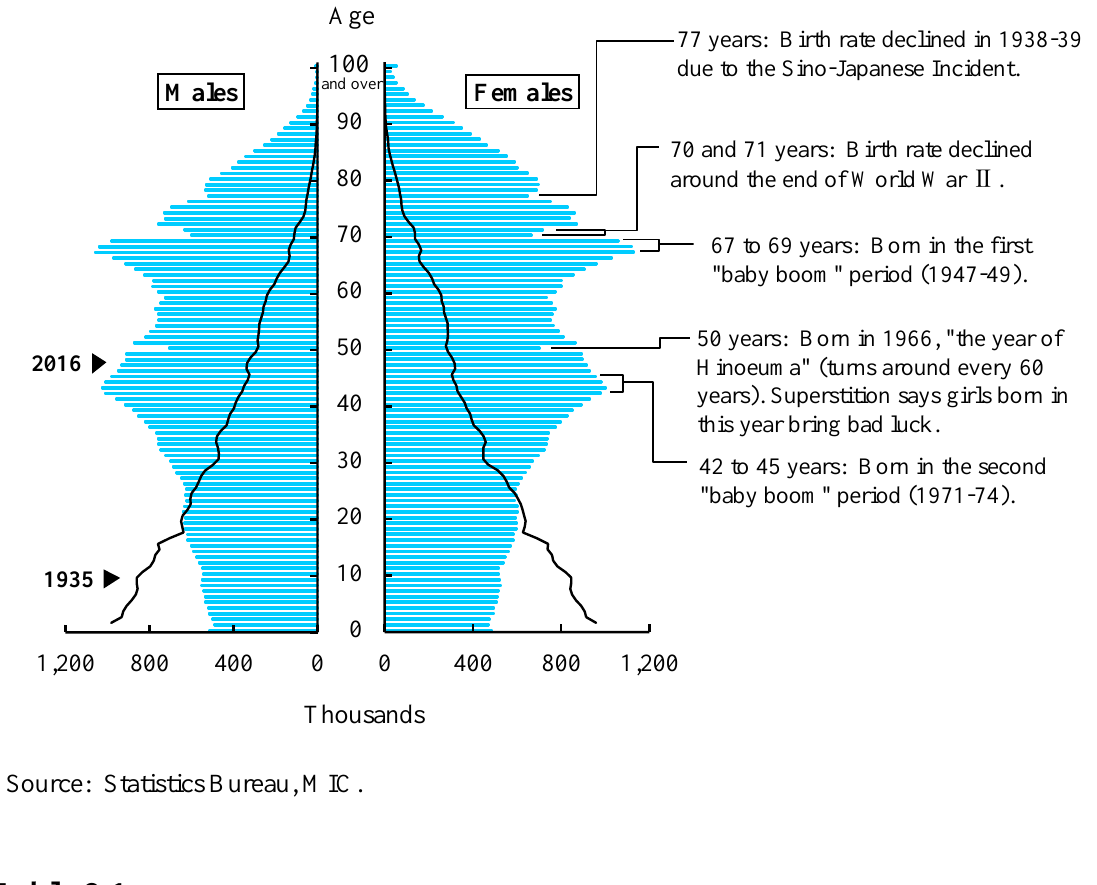
Table 2.1 Countries with a Large Population